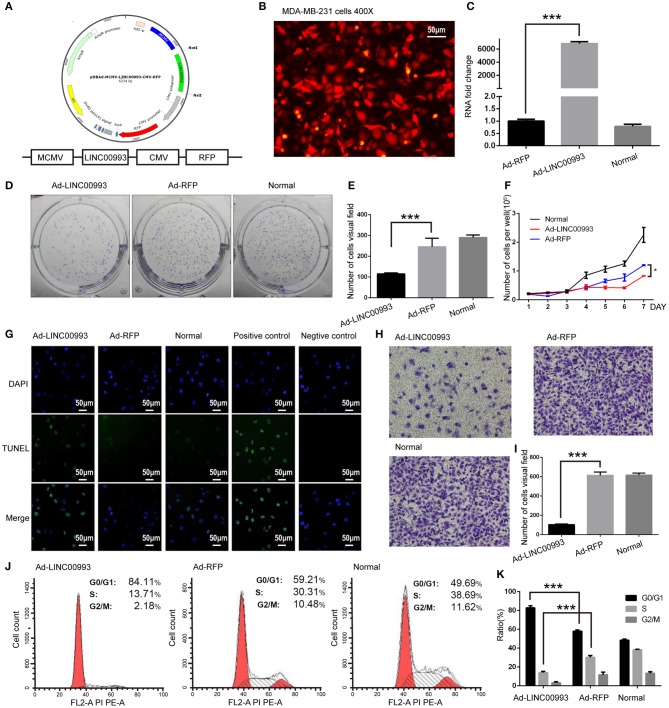
LINC00993 suppresses the growth of triple-negative breast cancer (TNBC) cells in vitro. (A) Structure of LINC00993 expression plasmid for adenovirus. (B) LINC00993 expression adenovirus infection efficiency showed by fluorescence microscope in MDA-MB-231 cells. Original magnification, ×400. Scale bars, 50 μm. (C) Expression of LINC00993 detected by qRT-PCR. MDA-MB-231 cells were infected by adenovirus for 24 h, and RNA was extracted. (D) Image of clone formation assay. (E) Number of clones were counted 2 weeks after plantation. (F) MDA-MB-231 cells were planted into 24-well plates. Twenty-four hours later, adenovirus was added to each well. Three wells of cells were digested and counted every 24 h. (G) LINC00993 expression caused apoptosis shown by TUNEL assay. Green points reflected apoptosis, and we used DAPI to stain DNA. Positive control cells were treated with DNase I, negative control cells were collected without adding TUNEL reaction buffer. Original magnification, ×100. Scale bars, 50 μm. (H) Effect of LINC00993 on cell cycle detected by flow cytometry. (I) Flow cytometry cell cycle results shown in a bar plot. (J) Invasive ability tested by Transwell assay. Twenty thousand cells were plated in each well, cells were observed after 24 h of incubation. (K) Bar plot for the number of cells that migrated across the membrane. ***P < 0.001, based on Student's t-test. Data were presented as mean ± SEM.